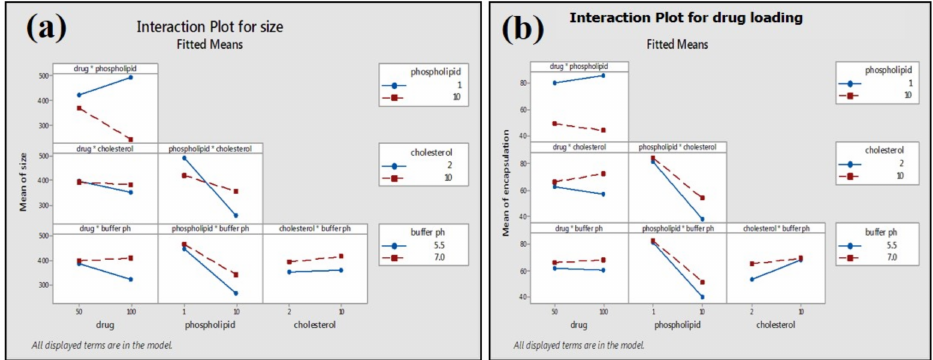
Figure 10. Interactions of MA on average particle size ( a ) and drug loading ( b ) of phytosome.